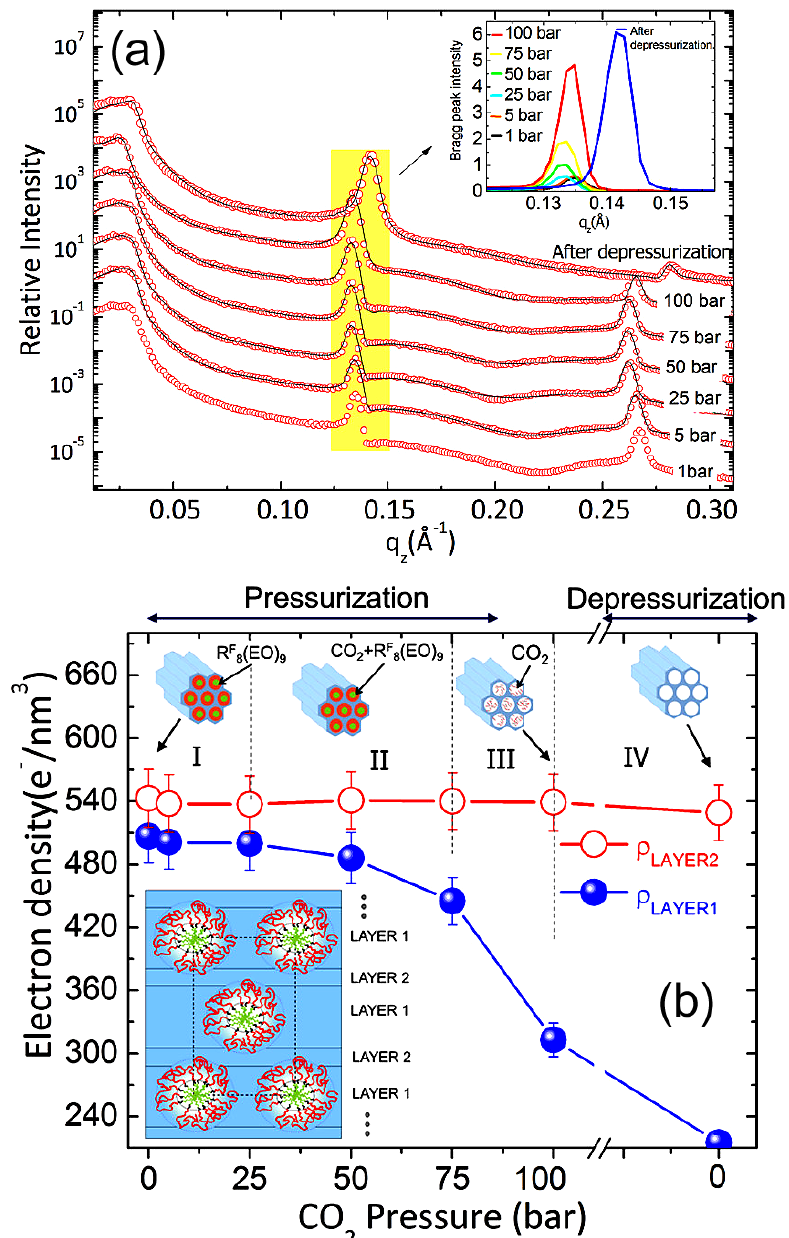
Figure 21. ( a ) Evolution of XRR profiles during in situ pressurization of CO 2 in the cell. Curves are translated vertically for clarity (logarithmic scale). In the top inset, a zoom of the evolution of the intensity is shown in a linear scale. ( b ) Evolution of the total electron density of the layer 1 and layer 2 during the pressurization and after the depressurization. Adapted from Chavez Panduro et al. [201] with permission from the American Chemical Society under ACS Author Choice